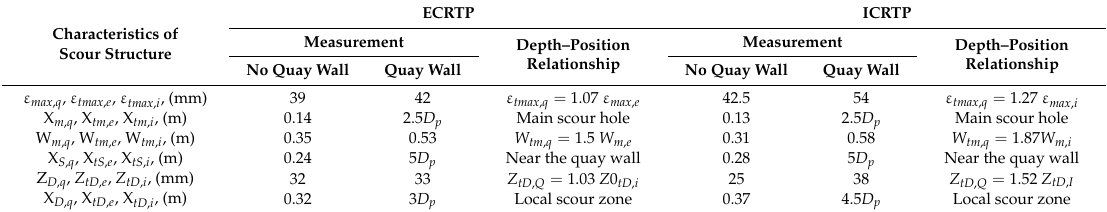
Table 5. Comparison of scour structures of external and internal rotating propellers at 5 D p away from quay wall.